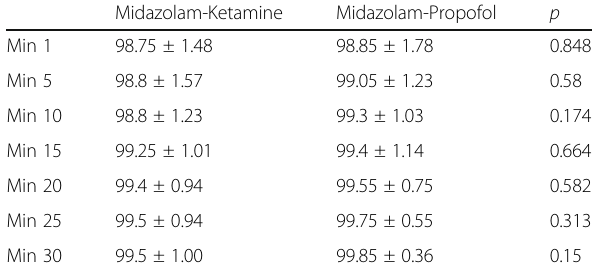
Table 6 SPO 2 values